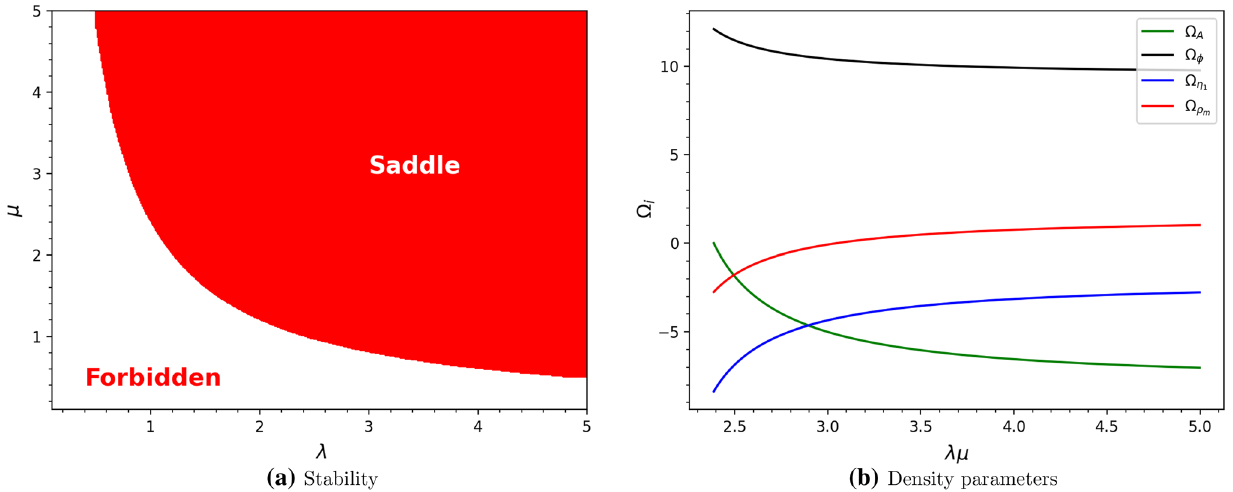
Fig. 6 On the left panel, the graph a shows the stability of the F ( B ) critical point. The saddle critical points lie in the red shaded region while non-shaded region is forbidden for critical points. On the right panel, the graph b illustrates the relation between density parameter